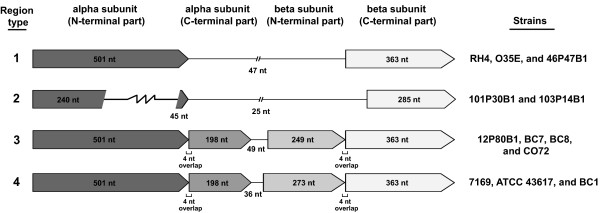
Overview of variant regions encoding putative succinyl-CoA:3-oxo-acid CoA-transferase (SCOT) subunits in M. catarrhalis strains. Four variant regions were identified: type-1 regions contain two ORFs encoding the N-terminal part of the alpha subunit and the C-terminal part of the beta subunit; type-2 regions hold the same ORFs but one with an internal deletion and one in a truncated form; type-3 regions have two sets of overlapping ORFs encoding the N-terminal (501 nt) and C-terminal part (198 nt) of the alpha subunit and the N-terminal (249 nt) or the C-terminal part (363 nt) of the beta subunit, respectively; type-4 regions are identical to type-3 regions except that the ORF encoding the N-terminal part of the beta subunit is 273 nt in length.